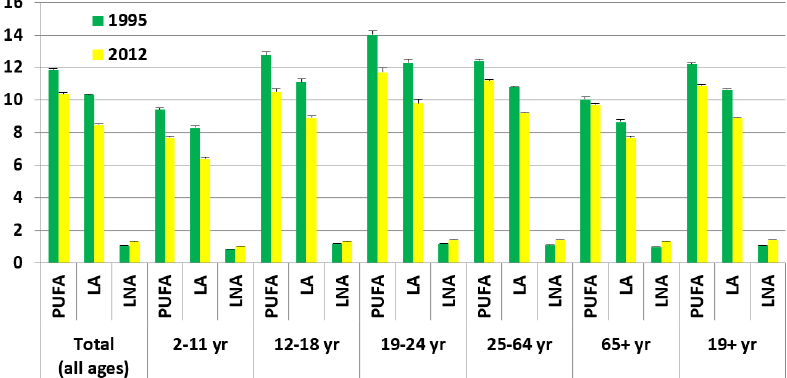
Figure 5. Comparison of the PUFA intakes (total PUFA, linoleic acid (LA), and alpha ‐ linolenic acid (LNA)) (g per day) per age category.